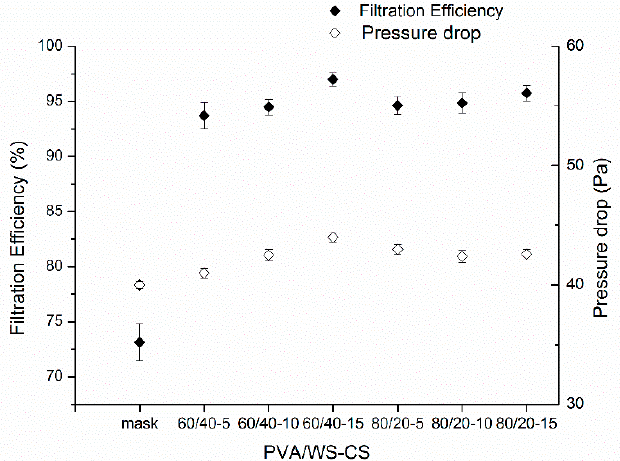
Figure 6. Filtration efficiency and pressure drop of PVA/WS-CS nanofibrous membranes.